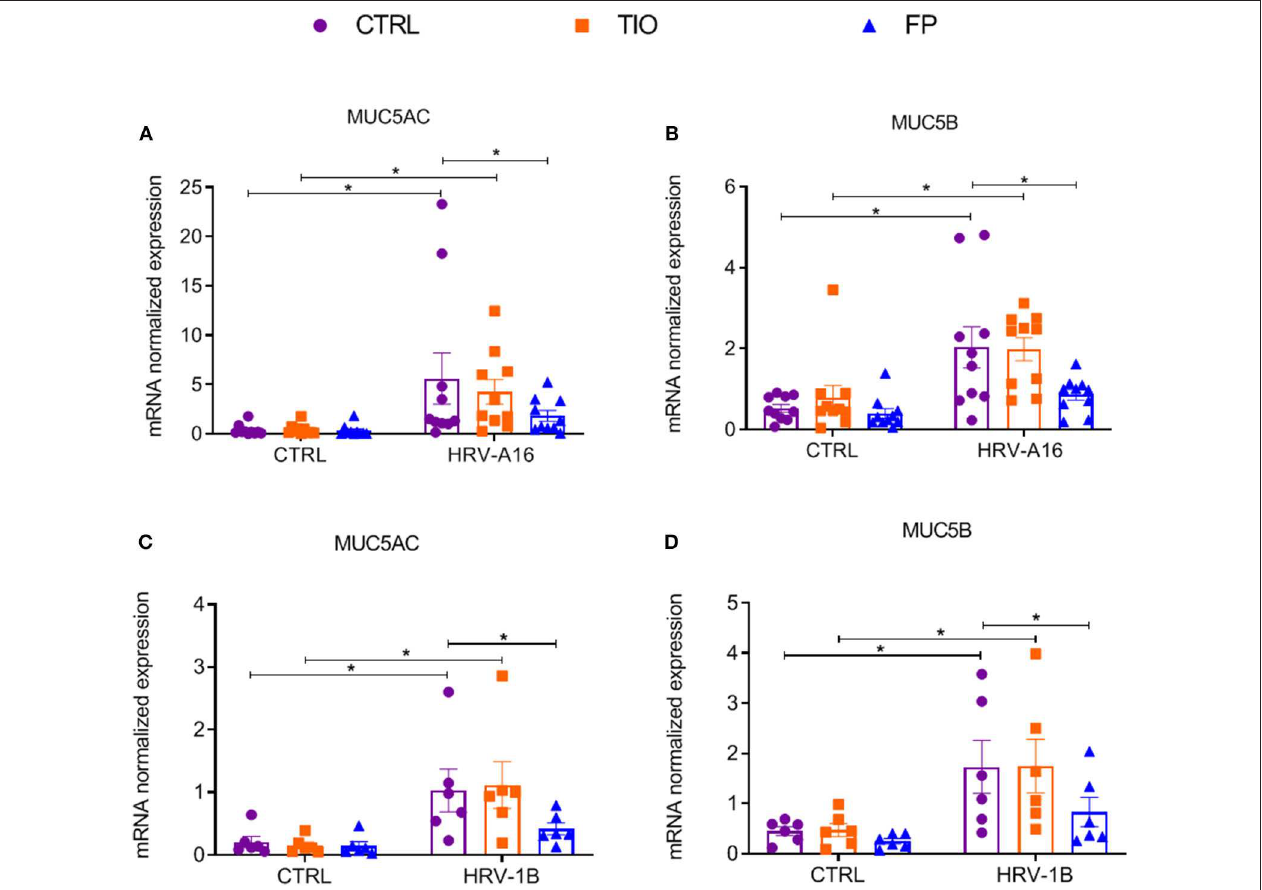
FIGURE 5 | Effects of tiotropium and fluticasone on expression of MUC5AC and MUC5B in ALI-PBEC. ALI-PBEC were pre-treated with tiotropium or fluticasone and infected with HRV-A16 (MOI 5). Cells were harvested at 48h after infection. The gene expression of MUC5AC (A,C) and MUC5B (B,D) were measured by real-time PCR. Data are mean values ± SEM. n = 10 or 6 independent donors. Data are shown as target gene expression normalized for RPL13A and ATP5B. Analysis of differences was conducted by two-way ANOVA with a Tukey post-hoc test Significant differences are indicated by * P < 0.05 compared with control or HRV-A16